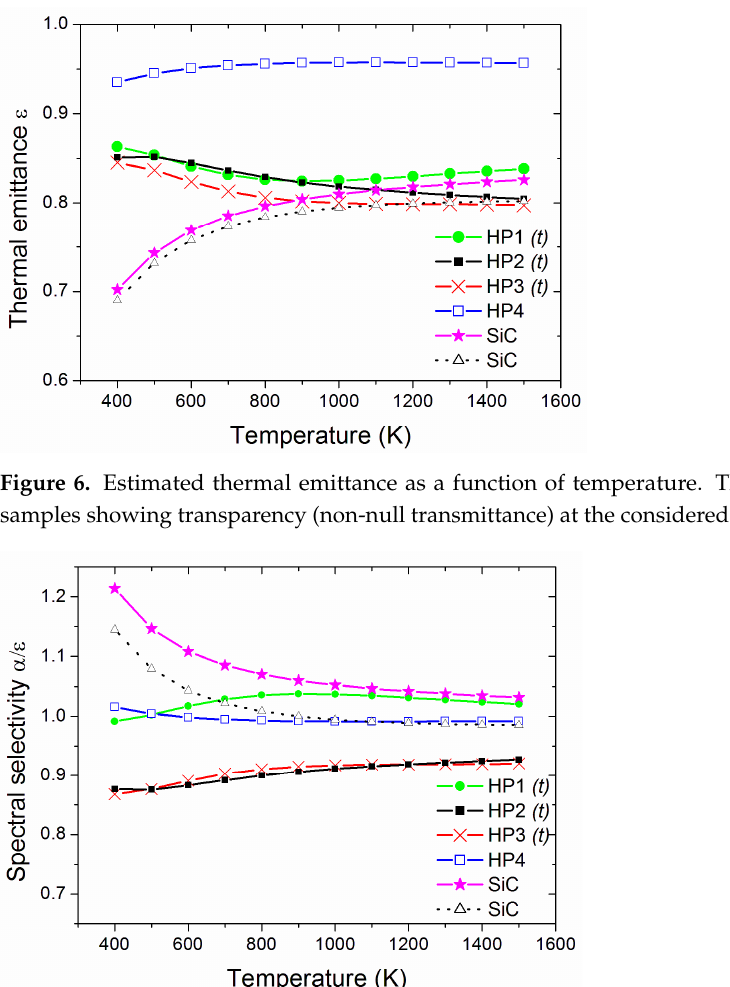
Figure 7. Estimated temperature-dependent spectral selectivity. The label (t) identifies the samples showing transparency (non-null transmittance) at the considered thicknesses.